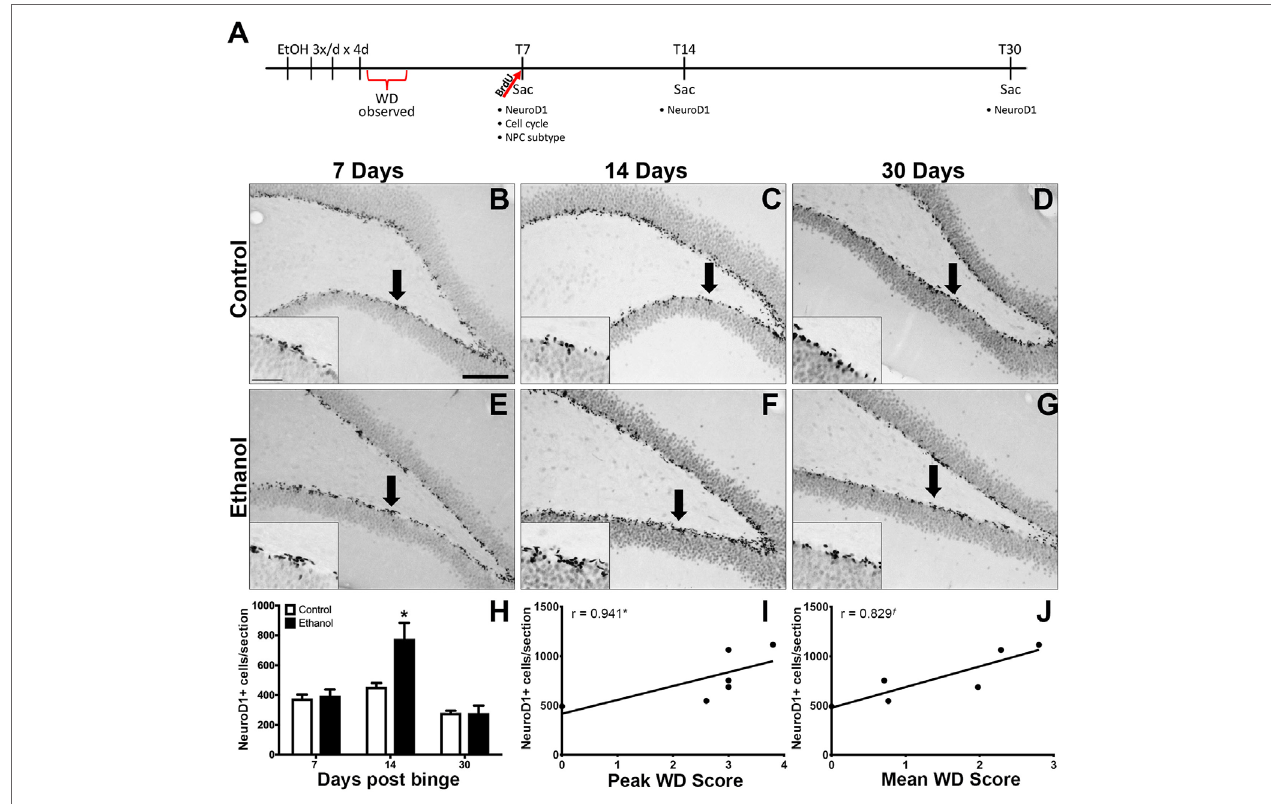
FigUre 1 | Reactive Neurogenesis confirmed with NeuroD1. (a) Experimental timeline is shown. Increased proliferation along the subgranular zone (SGZ) at T7 (67) is followed by enhanced NeuroD1 expression. (B–g) Representative images show NeuroD1 immunoreactivity present along the inner side of the granule cell layer in control (B–D) and ethanol (e–g) rats after 7, 14, and 30 days post the final dose of alcohol. Arrows point to areas represented in insets. Scale bars = 100 µm. (h) Profile counts revealed that the number of NeuroD1 + cells located in the SGZ increased significantly 14 days after binge ethanol exposure. (i,J) Spearman’s correlation shows a positive relationship between 14-day NeuroD1 + cell counts and peak withdrawal score (i) and mean withdrawal score (J) . * p < 0.05. † p =